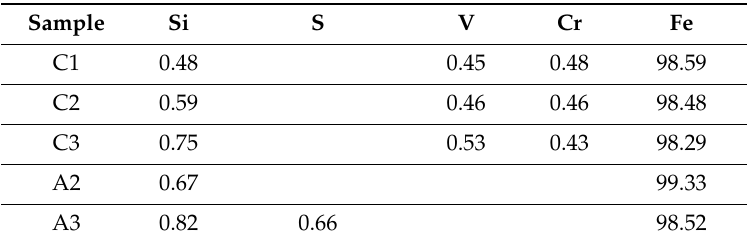
Table 5. SEM-EDS general chemical composition of some samples of obtained cast iron (% by weight) and microhardness value of the perlitic